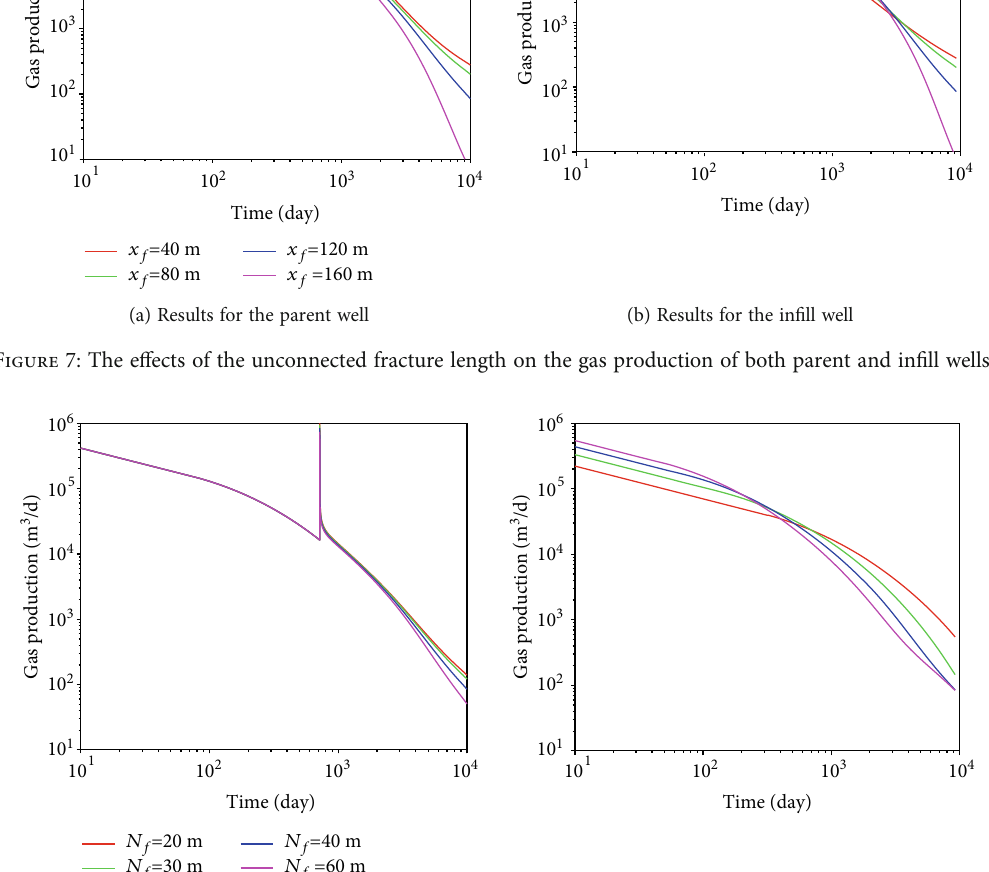
(b) Results for the in fi ll well